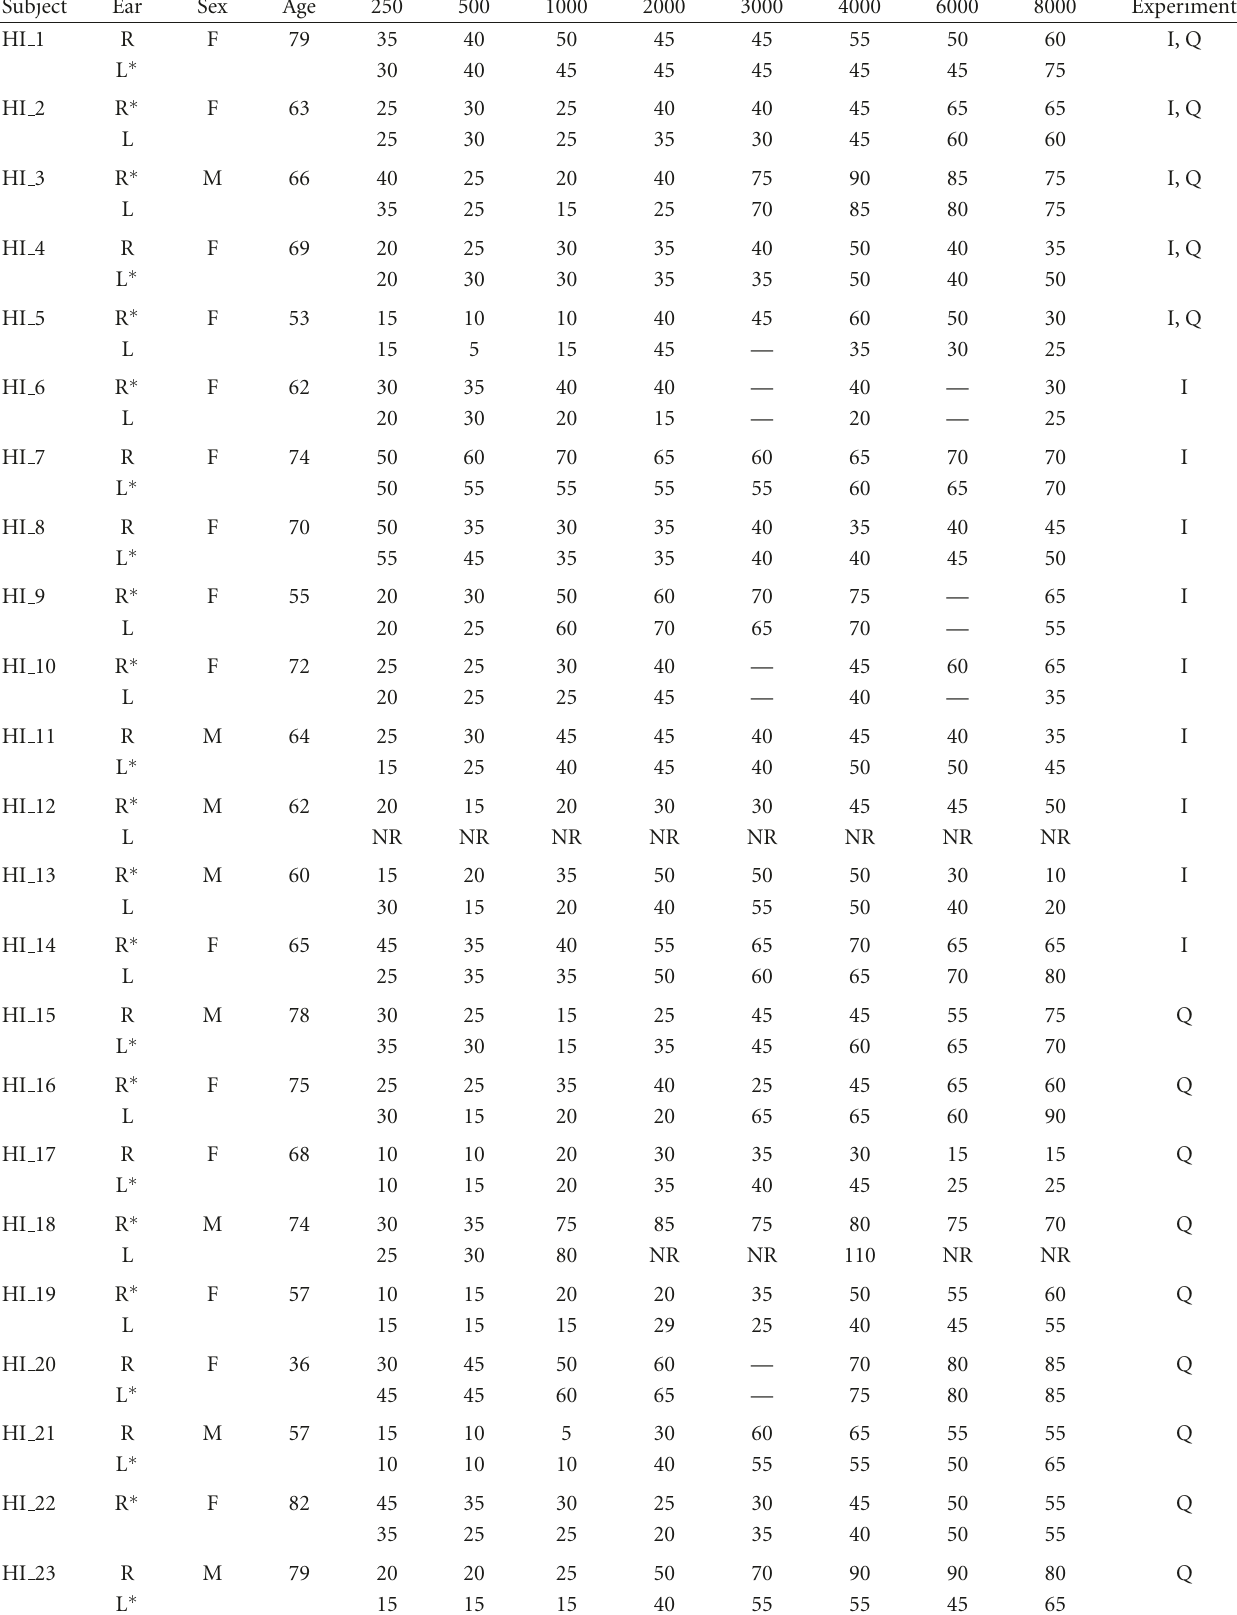
Table 1: Listener thresholds. Test ear is marked with an asterisk. I = intelligibility participant, Q = quality